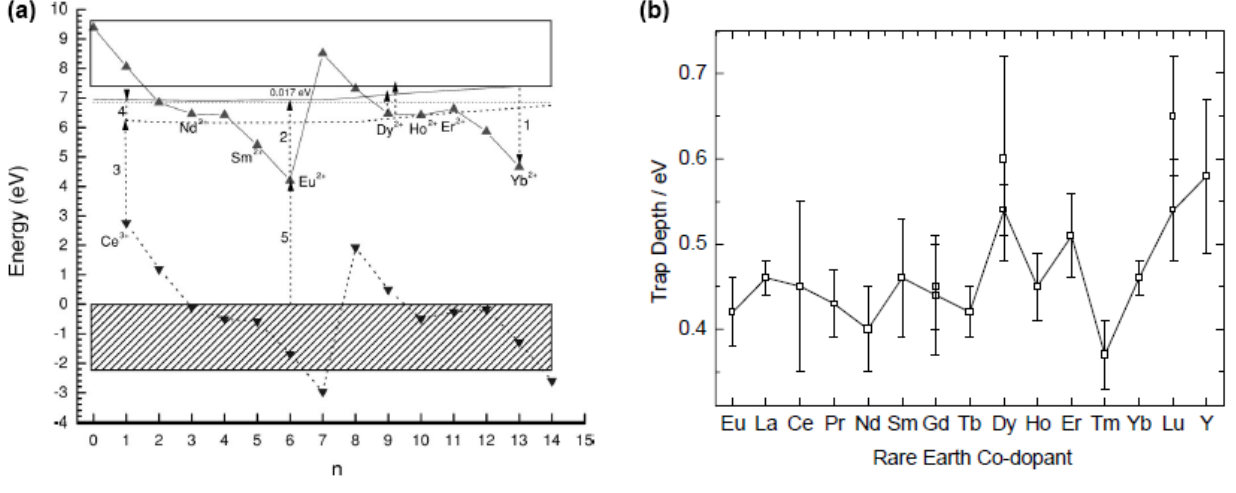
Figure 12. (a) Typical energy level pattern for the lanthanide series (n = number of 4f electrons) in SrAl O :Eu 2+ ,RE 3+ (Reprinted with permission from [10]. Copyright 2005, 2 4 The Electrochemical Society) (b) Trap depths estimated with the Hoogenstraaten method for different codopants in CaAl O :Eu 2+ ,RE 3+ (Reprinted with permission from 2 4